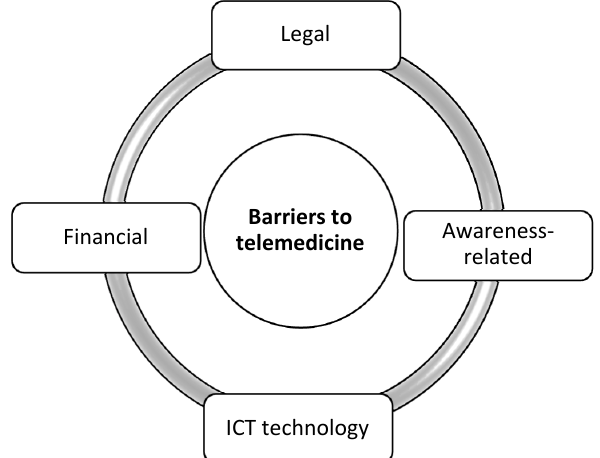
Figure 1. The areas of the most common barriers related to the use of telemedicine in the world [13].